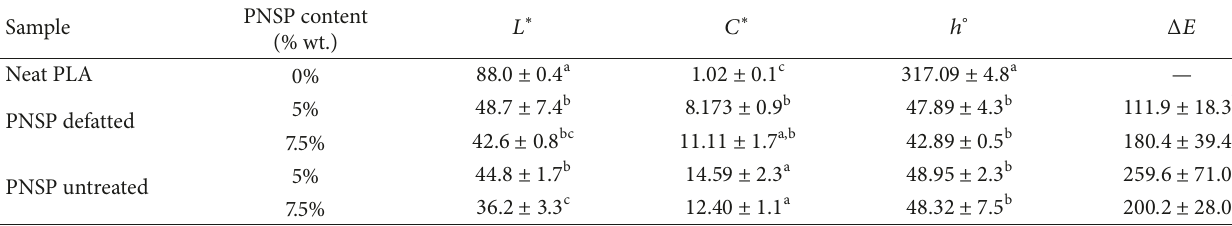
Table 1: Color parameters of the PLA-PNSP biocomposites ∗ .